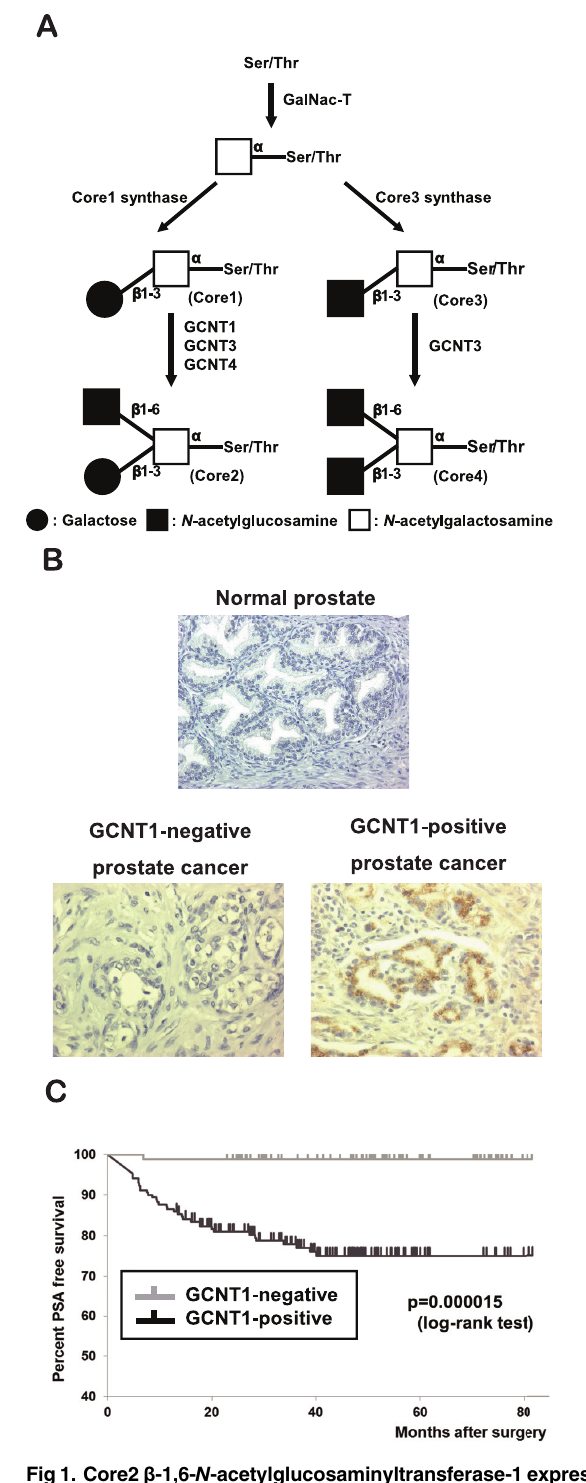
PLOS ONE | DOI:10.1371/journal.pone.0138520 September 21,